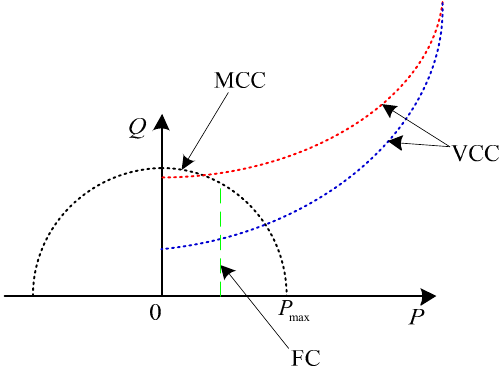
Figure 3. Controllable operation region of the VSC ‐ HVDC inverter.